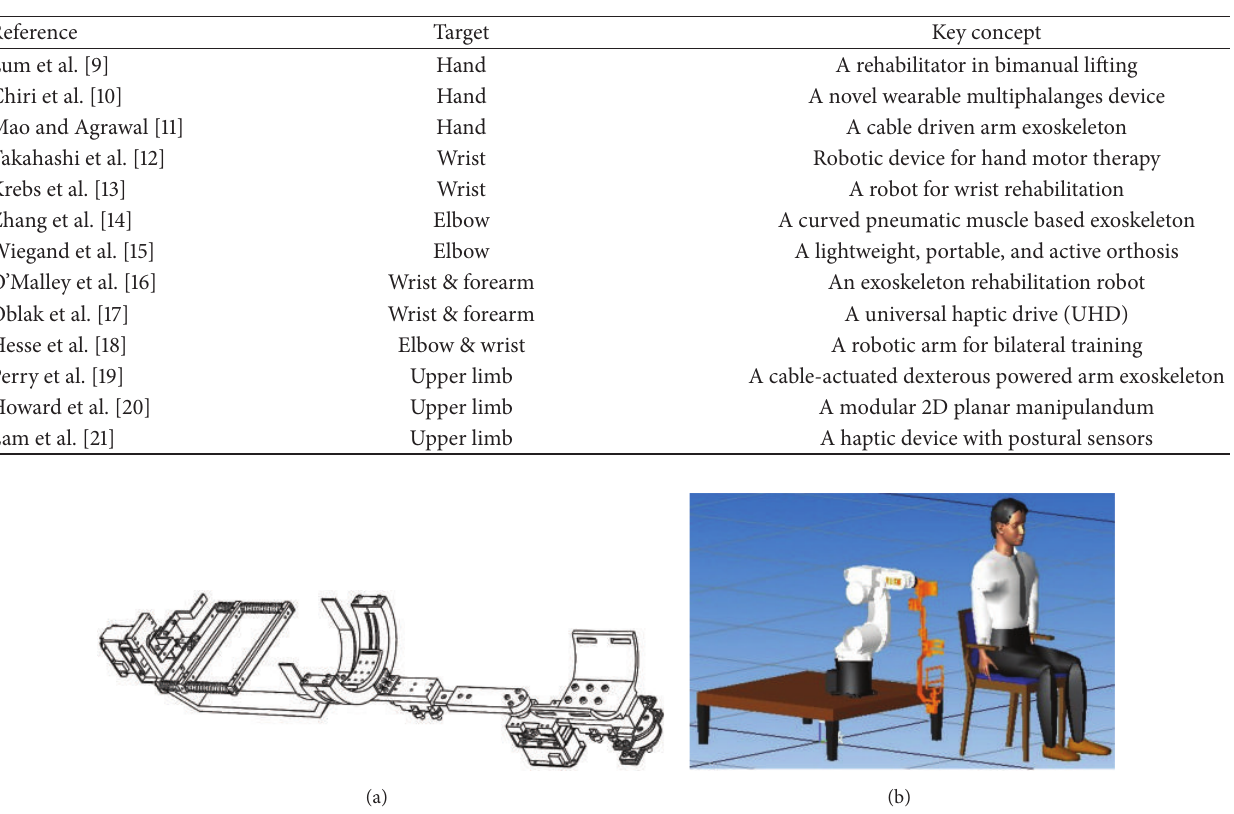
Table 1: Examples of robotic rehabilitation.